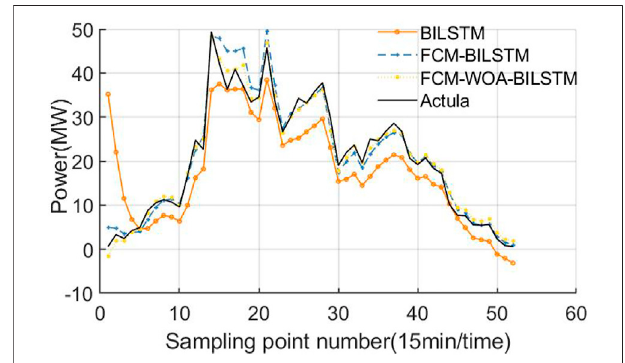
FIGURE 5 | 14 June 2019 (sunny).